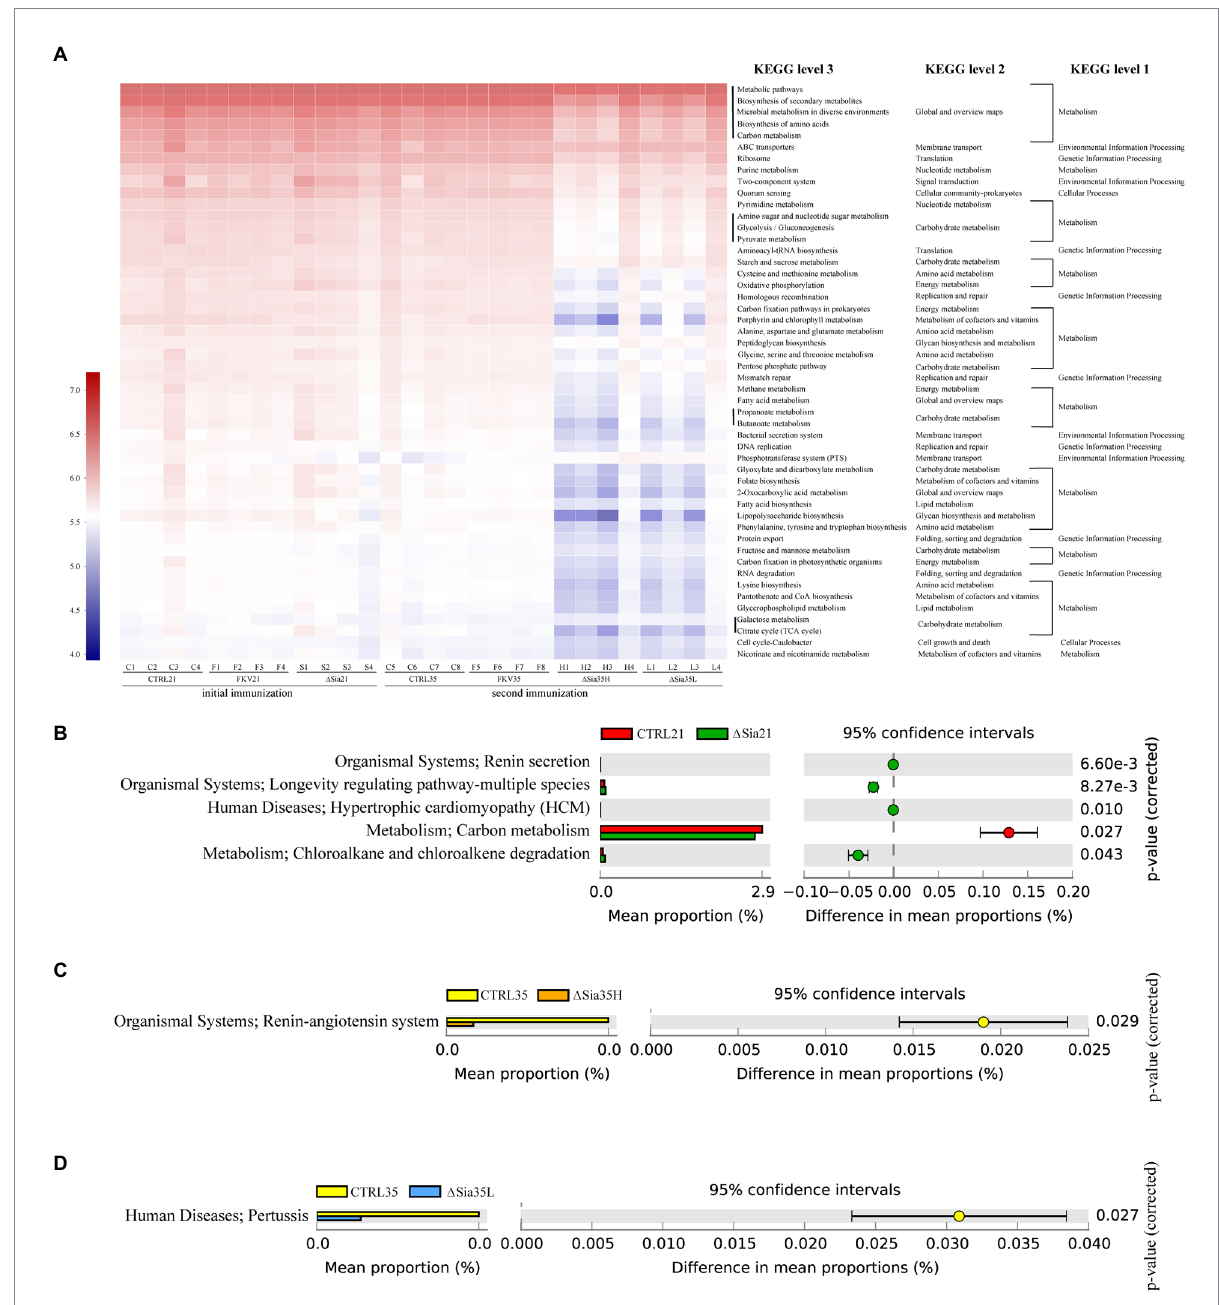
FIGURE 5 (A) KEGG functional prediction of bacterial communities based on PICRUSt2. The horizontal axis represents the sample name, and the vertical axis represents the functional category. Color intensities indicate the abundance of sample functional categories, and legends are shown on the left side of the plot. STAMP was used to process the functional profiles of gut microbial communities predicted by PICRUSt2, and the metabolic pathways at KEGG level 3 that differed significantly between (B) CTRL21 and ∆ Sia21, (C) CTRL35 and ∆ Sia35H, and (D) CTRL35 and ∆ Sia35L were identified through Welch’s t -test with a 95% confidence interval (Bonferroni’s multiple test correction). On the basis of same statistical hypothesis testing, no significant differences in functional profiles were found between CTRL21 and FKV21 and between CTRL35 and FKV35. CTRL21 (C1–C4), control group at 21 dpiv; FKV21 (F1–F4), FKV group at 21 dpiv; ∆ Sia21 (S1–S4), LAV ∆ Sia group at 21 dpiv. CTRL35 (C5–C8), control group at 35 dpiv; FKV35 (F5–F8), FKV vaccine group at 35 dpiv (14 days after the second immunization); ∆ Sia35H (H1–H4), LAV ∆ Sia group with a high serum antibody response at 35 dpiv (14 days after the second immunization); ∆ Sia35L (L1–L4), LAV ∆ Sia group with a low serum antibody response at 35